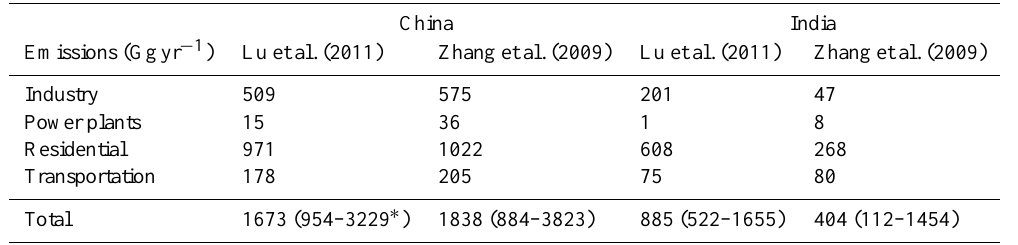
Table 4. Anthropogenic BC emissions in China and India in